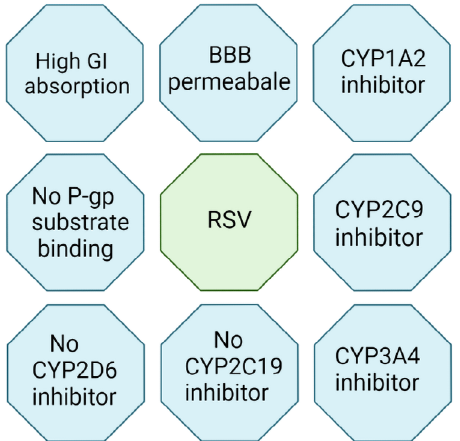
Figure 3. Pharmacokinetic properties of RSV. CYP1A2: cytochrome P450 1A2; P-gp: P-glycoprotein; CYP2C9: cytochrome P450 2C9; CYP2D6: cytochrome P450 2D6; CYP3A4: cytochrome P450